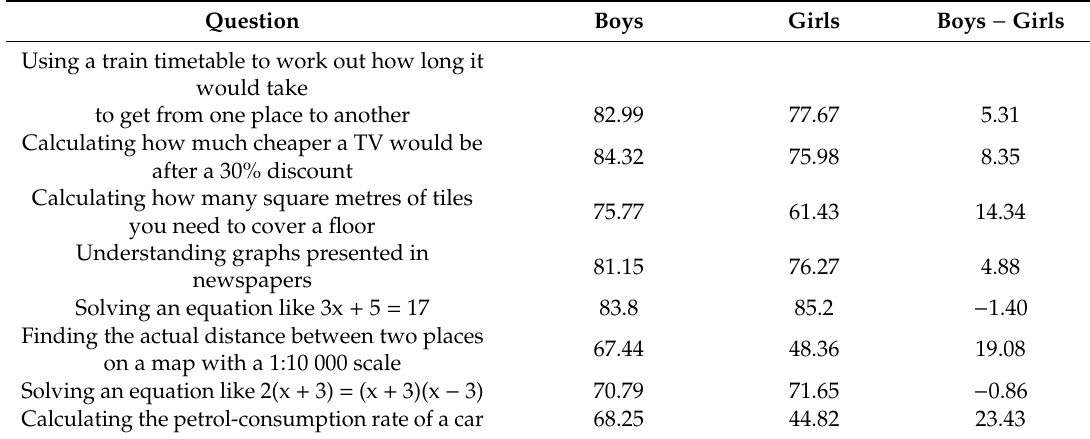
Table A7. Math Self-E ffi cacy PISA Questions.